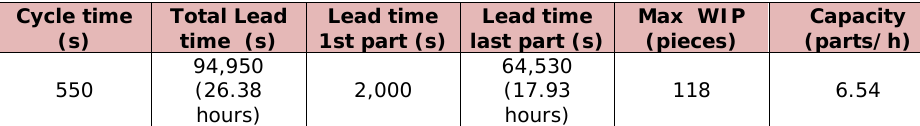
Table 4. “Key metrics after balancing the production